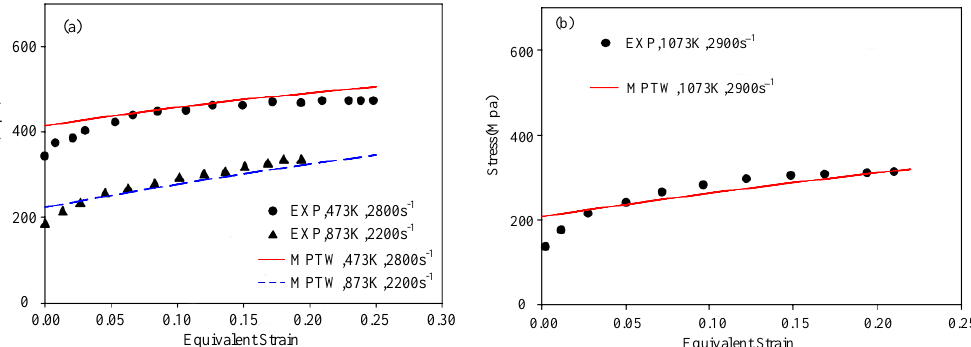
Figure 18. The predicted flow stresses of tantalum based on the modified PTW model [43]. ( a ) T =473 K, 𝜀̇ = 2800𝑠 −1 , T =873 K, 𝜀̇ = 2200𝑠 −1 , ( b ) T =1073 K, 𝜀̇ = 29001𝑠 −1 .